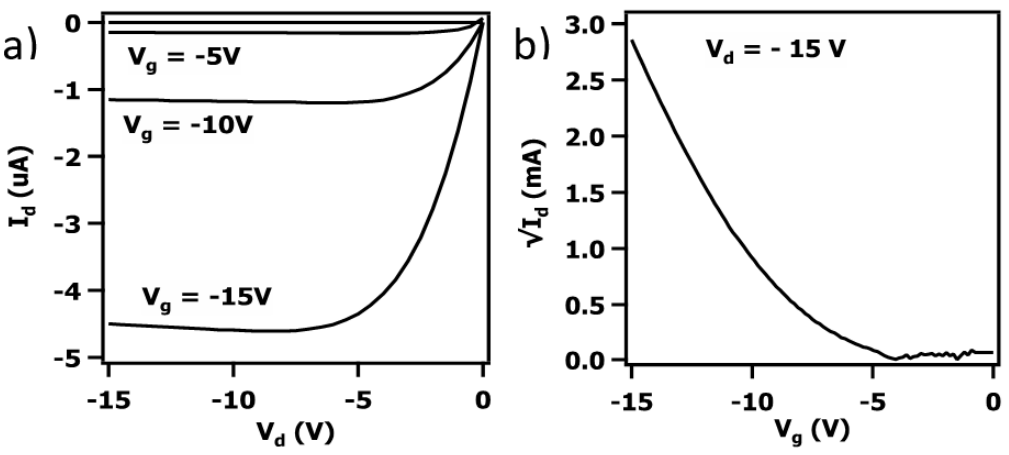
Figure 3. ( a ) Output characteristics of pentacene OTFTs with PS as the polymer electret at V g = 0 V, − 5 V, − 10 V, and − 15 V; ( b ) Transfer curve of the pentacene-based OTFTs with PS electret at V d = − 15 V;